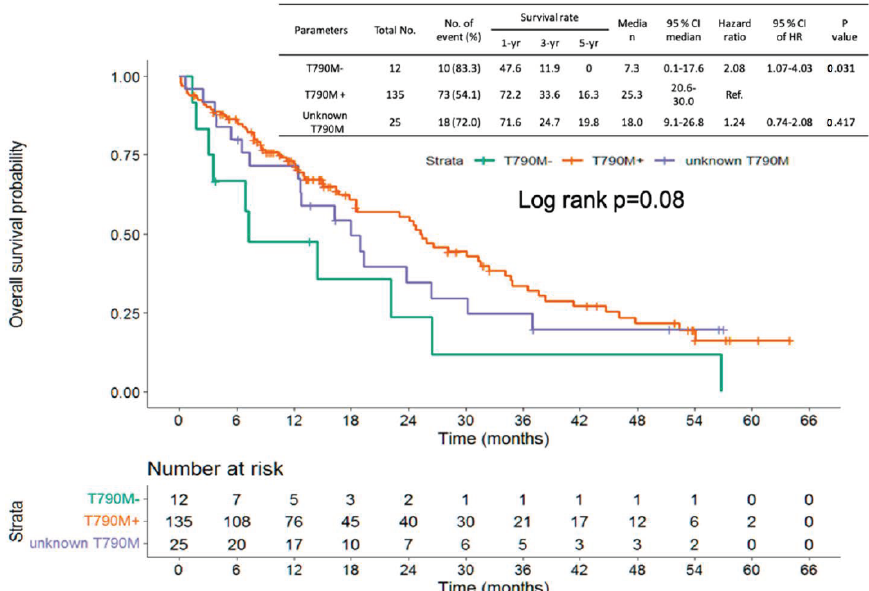
Figure 6. Overall survivals from osimertinib based on T790M status.